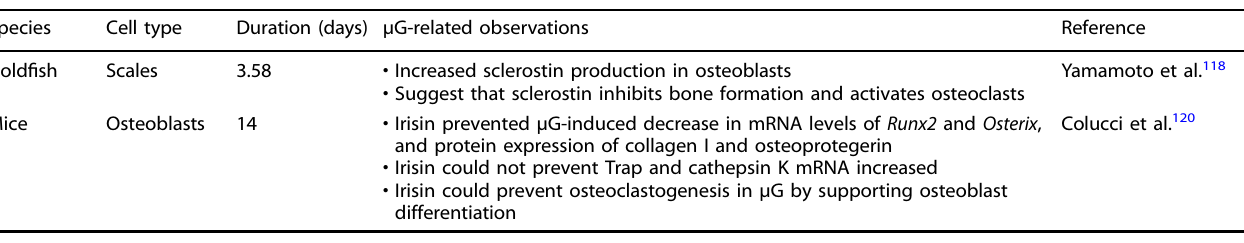
Summary of observations in animals and bone cells from various studies during space fl ights compared to respective ground controls. GC ground control, TRAP tartrate-resistant acid phosphatase, MMP-9 matrix metallopeptidase 9, BDSC blood-derived stem cells, BMSC bone marrow stem